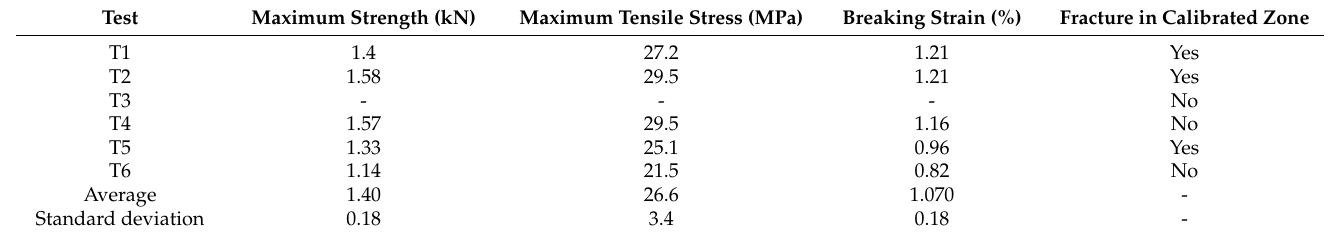
Table 6. Summary of results of the tensile tests on specimens produced by SLA 3D printing.